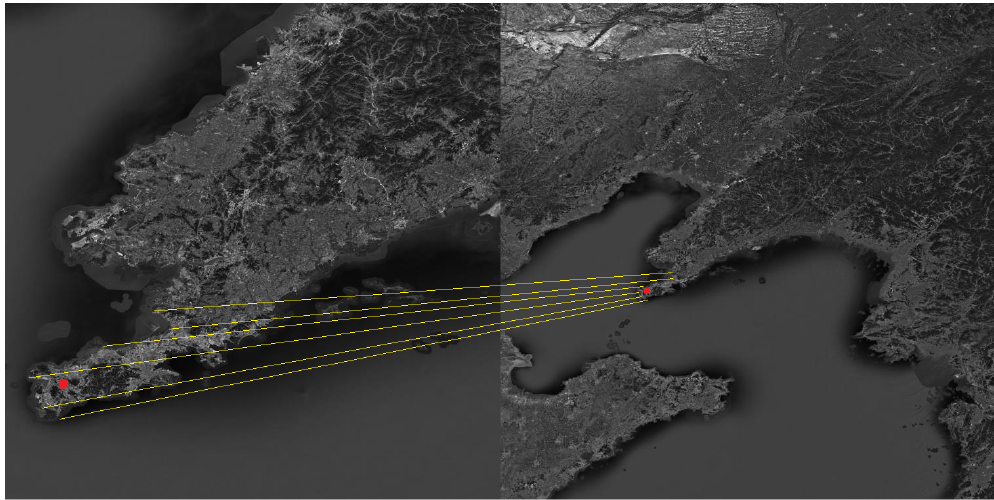
Figure 6. Schematic diagram of the matching process about the Liaodong